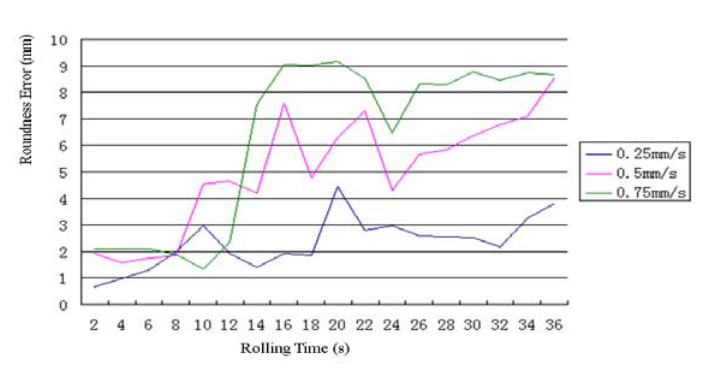
Fig. 12. The relation curves between the feed speed of the taper roller and the roundness error